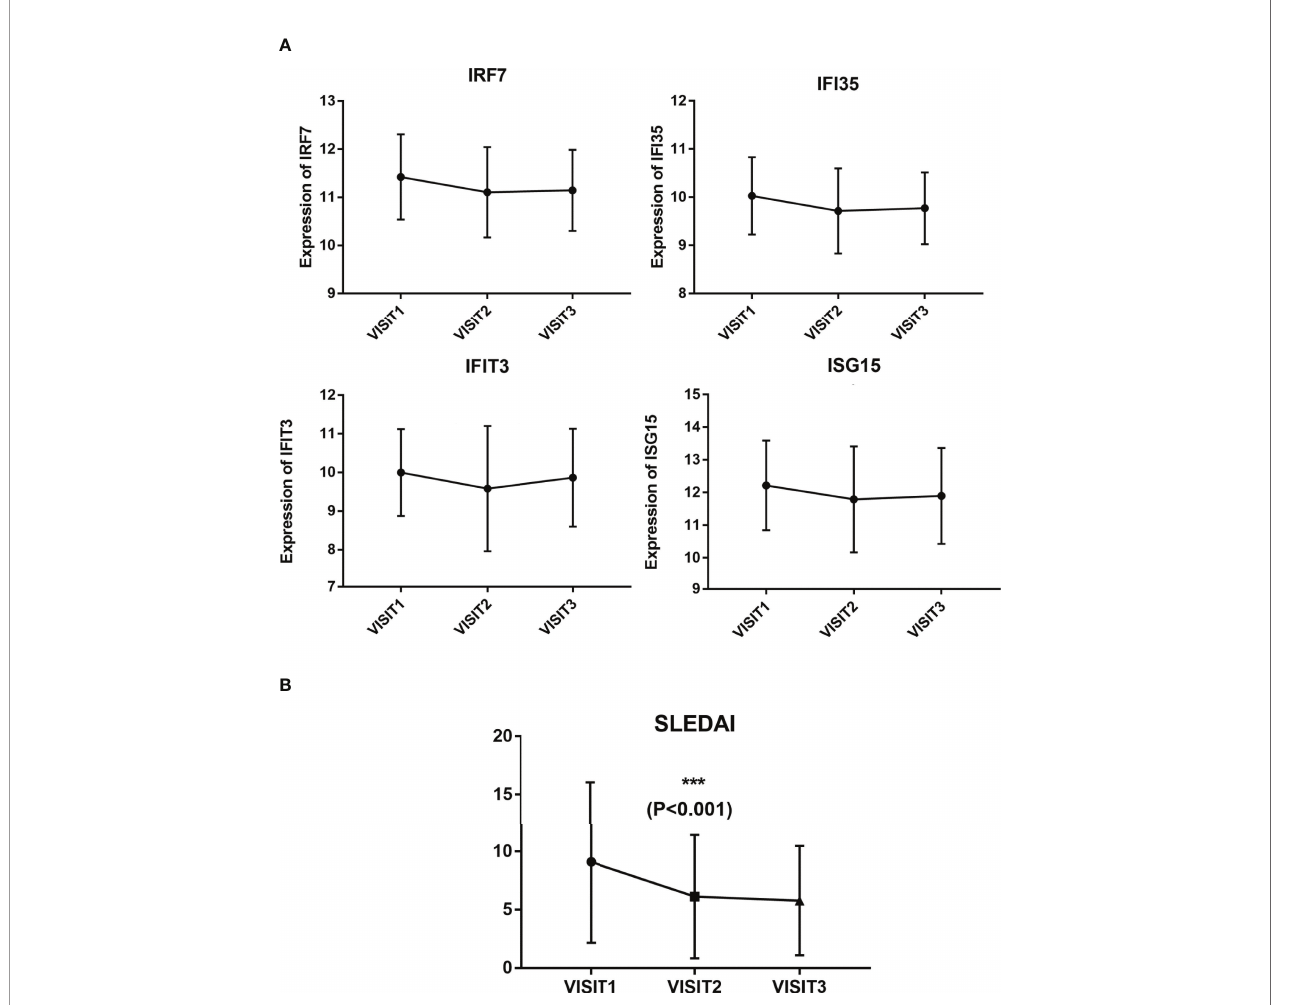
FIGURE 4 | Expression levels of the four hub genes and SLEDAI during follow-up. (A) Expression levels of IRF7, IFI35, IFIT3, and ISG15 in three visits. (B) SLEDAI in three